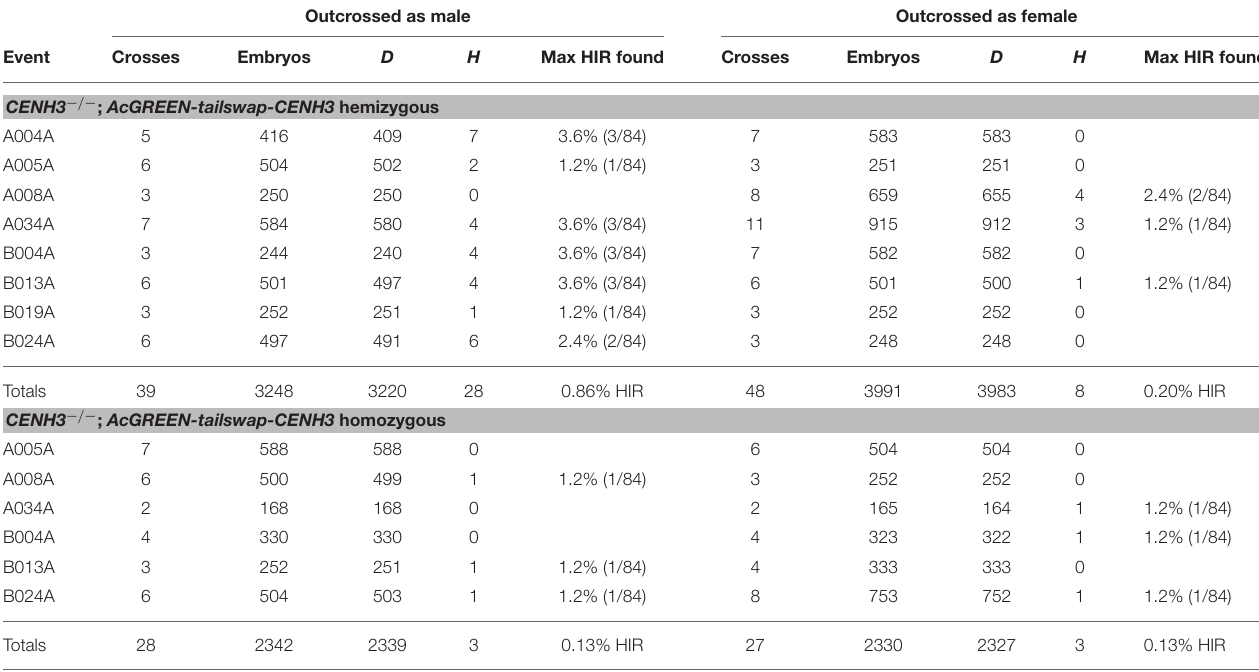
The columns labeled “D” refer to the diploid embryo count. The columns labeled “H” refer to the haploid embryo count. The columns labeled “Max HIR found” refer to the highest rate of haploid induction found among all the crosses made using individuals from the given event. The average induction frequency when the transgenic line was hemizygous on the male side of the cross was 0.86%, which is significantly higher than background (Z = 4.61, p < 0.01). All other crossing strategies produced haploids at rates that were not significantly different compared to